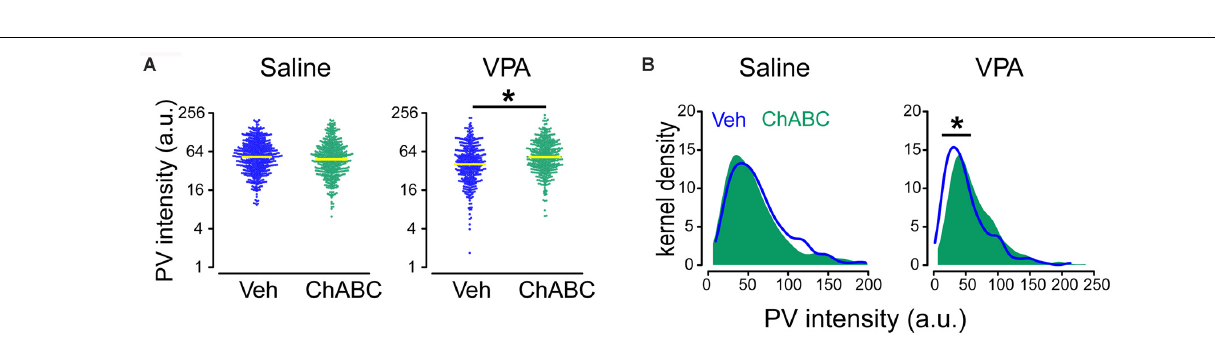
FIGURE 4 | Different assumptions of a distinct subpopulation in VPA adults. (A1,B1,C1,D1) Relationships between PV and PNN intensities for two subpopulations in adult VPA mice. Dark green and orange dots are “abnormal” and “normal” subpopulations. Dark green and orange lines represent the relationship between the logarithm transformations of PV intensity [log(PV)] and PNN intensity [log(PNN)]: log(PV) = a × log(PNN) + b. For (A1) , “normal” subpopulation: a = 0.25, b = 0.04; “abnormal” subpopulation: a = − 0.27; b = 0.21. For (B1) , “normal” subpopulation: a = 0.24, b = 0.04; “abnormal” subpopulation: a = − 0.19; b = 0.06. For (C1) , “normal” subpopulation: a = 0.18, b = 0.04; “abnormal” subpopulation: a = − 0.17; b = 0.10. For (D1) , “normal” subpopulation: a = 0.15, b = 0.04; “abnormal” subpopulation: a = − 0.20; b = 0.07. (A2,B2,C2,D2) Boxplots of fractions of “abnormal” subpopulation in adult mice for saline and VPA groups. Thick lines in boxes indicate medians of fractions. The lower and upper bounds of boxes represent the 1st (Q1) and 3rd quartiles (Q3) of fractions. IQR = Q3 − Q1. Thin lines located outside boxes are the minimum fractions and the smaller of the maximum fractions and Q3+1.5 × IQR. Circles were used to indicate values outside the ranges between Q1–1.5 × IQR and Q3 + 1.5 × IQR. Fractions of “abnormal” subpopulation in adult mice of VPA and saline groups were compared using the Mann–Whitney U test. * P < 0.05, *** P < 0.001.